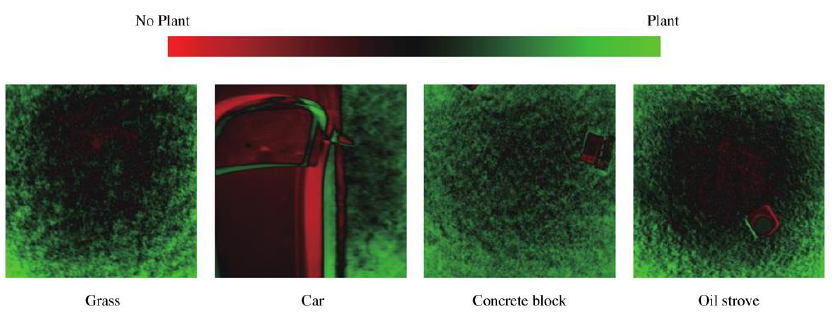
Figure 23. Evaluation of aerial images using the NDVI.